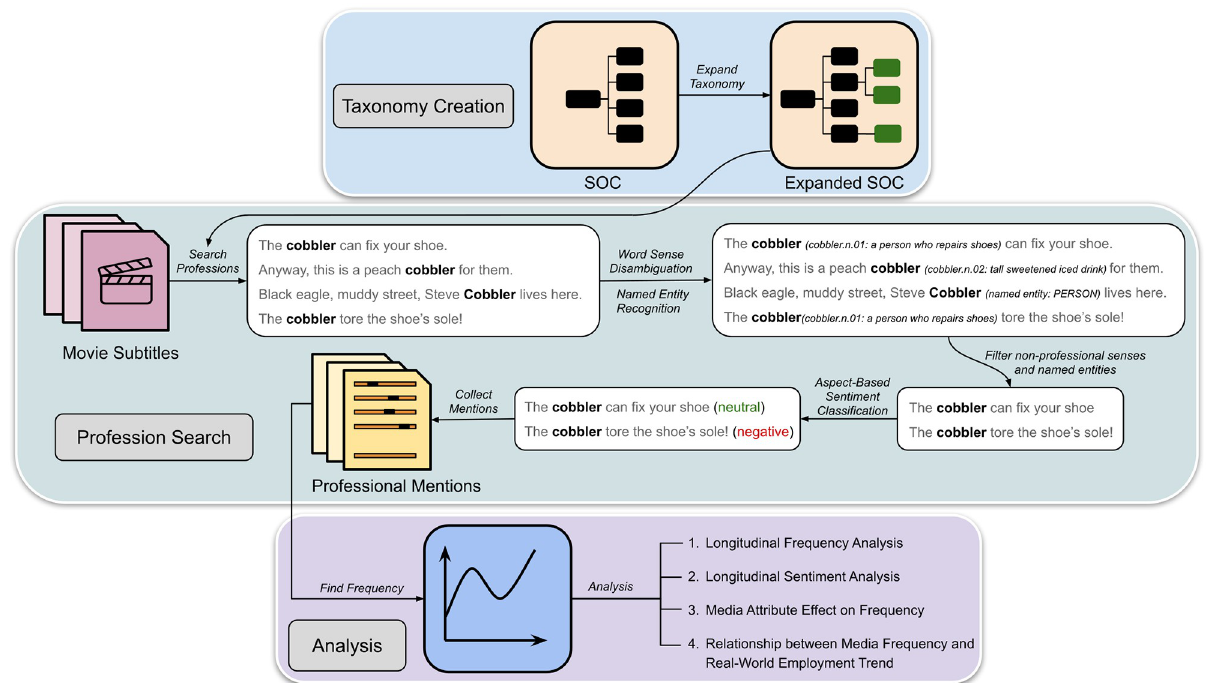
Fig 3. Profession taxonomy creation and analysis. The full pipeline for creating the profession taxonomy and the corpus of professional mentions, and analyzing the subtitle frequency and sentiment of professions.